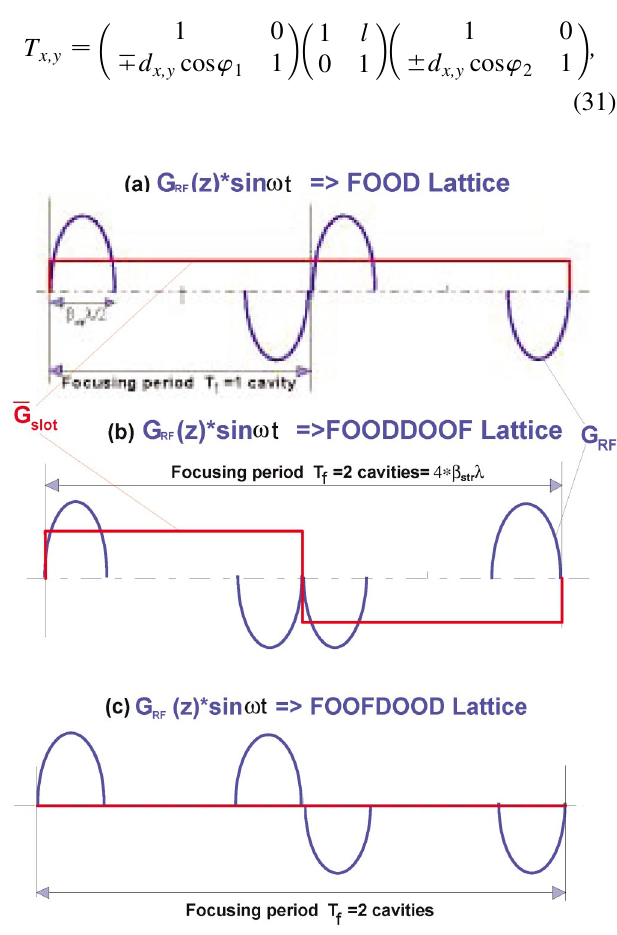
FIG. 11. (Color) Three options for the rf and the slot gradient